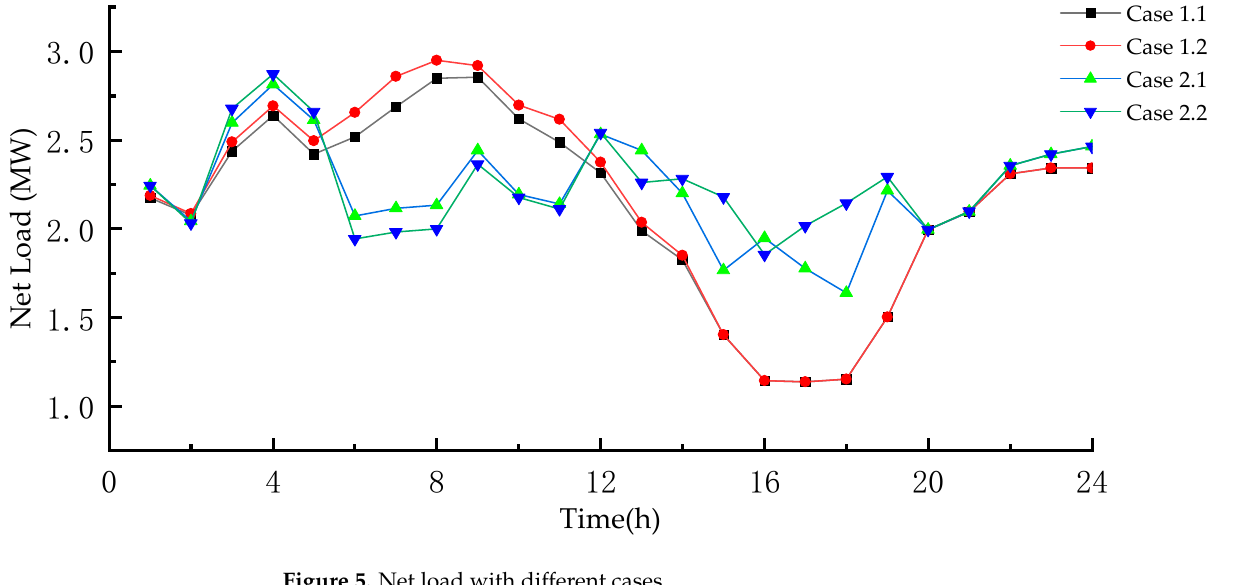
Figure 5. Net load with different cases. Table 3. The different cost between different cases.